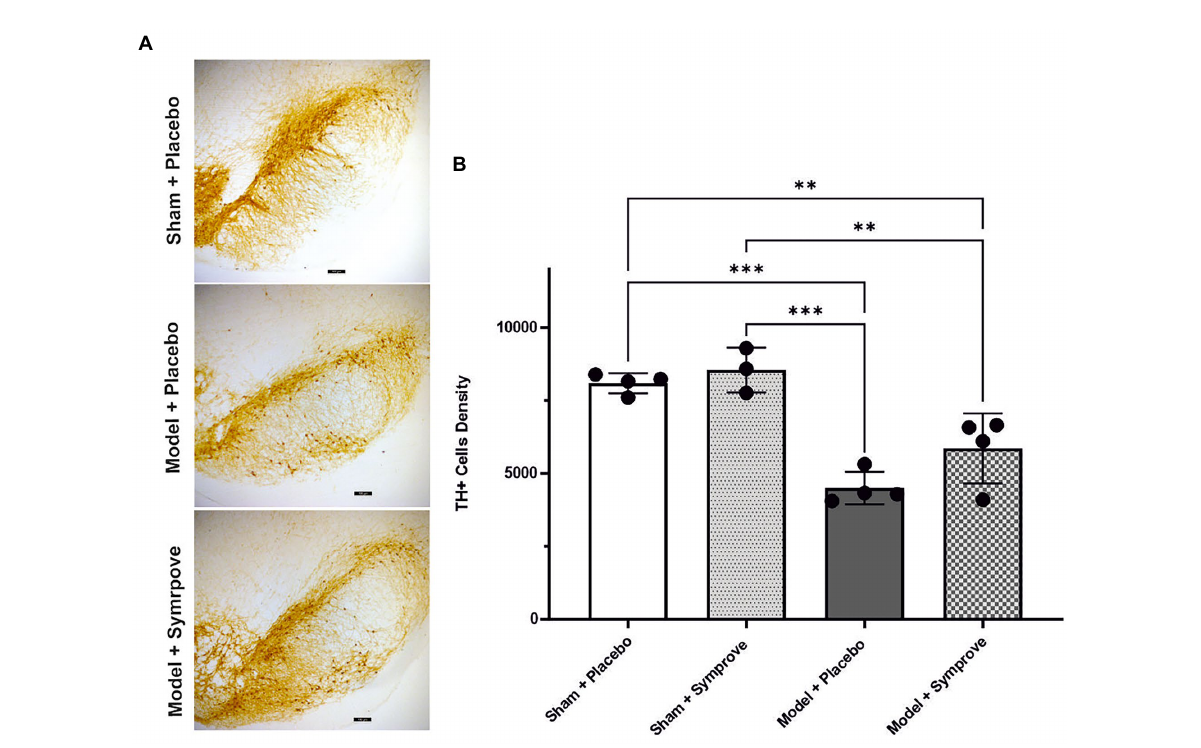
FIGURE 11 Effect of Symprove ™ on neurodegeneration in the SNpc (Substantia Nigra pars compacta) of all experimental groups: Sham + placebo, Sham + Symprove ™ , model + placebo and model + Symprove ™ . (A) Representative images of TH-staining in the substantia nigra pars compacta (SNpc) in a sham animal and PD model animal treated with placebo and a model treated with Symprove ™ . Scale bars represent 100 μ m. (B) Number of TH-positive cells in the SNpc expressed as cell density per mm 3 . A decrease in the number of TH-positive cells was observed in the model treated with placebo compared with the shams treated with placebo and Symprove ™ (ANOVA, p < 0.001). Symprove ™ prevented the loss of TH-positive cells by ~17% compared with models treated with placebo. All data are shown as mean ± S.E.M. ** p < 0.01, *** p <